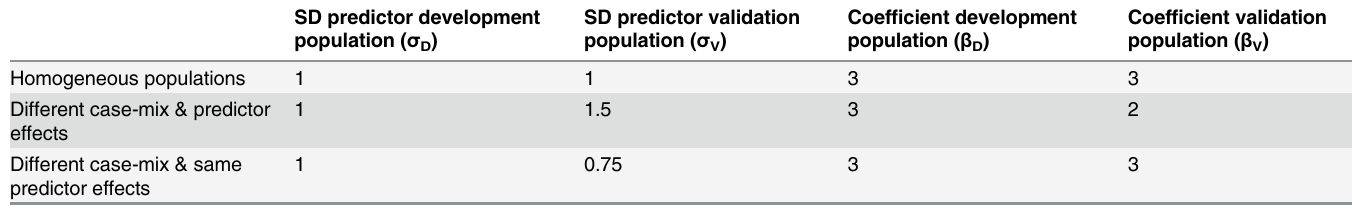
Table 1. Parameters of the different scenarios in the simulation